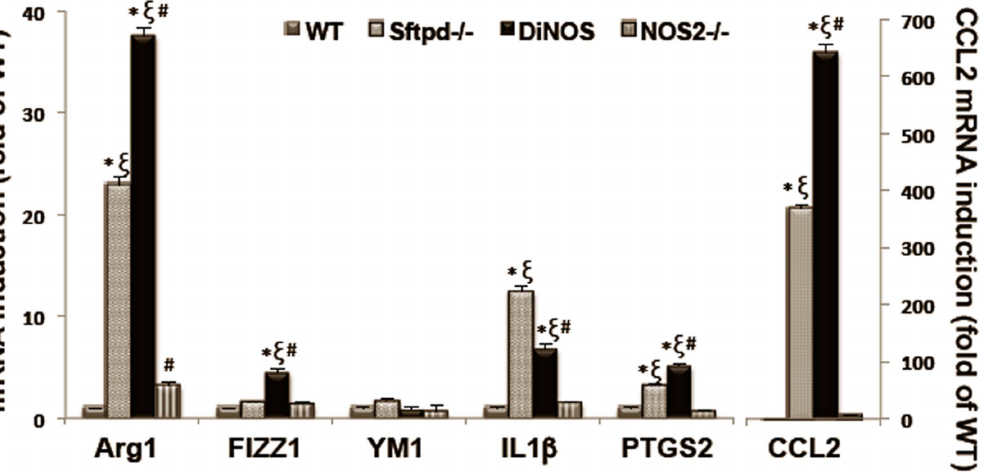
Figure 8. NOS2 ablation alters the inflammatory phenotype of BAL in DiNOS mice. RNA was extracted from BAL cells isolated from WT, Sftpd 2 / 2 , NOS2 2 / 2 and DiNOS mice. Gene markers were quantified by RT-qPCR as described. Ct values obtained were normalized to b -actin signals and further analyzed using the relative quantization ( DD Ct) method. Data are expressed as fold change (means 6 S.E.M, n=5–8 in each group). Statistically significant differences between groups (p , 0.05) are indicated as: * vs WT, j vs NOS2 2 / 2 , # vs Sftpd 2 / 2 .